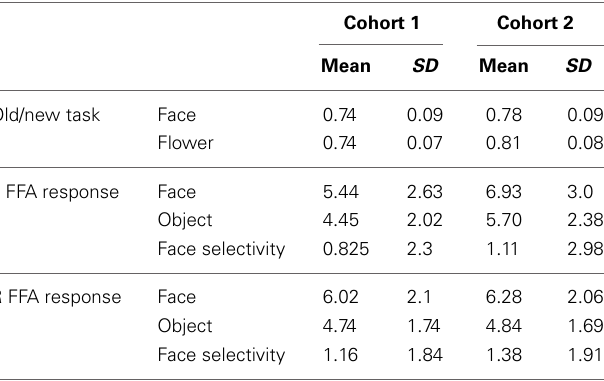
Table 2 | Mean Scores and standard deviations ( SD ) of the performance in the old/new recognition task and the FFA responses.